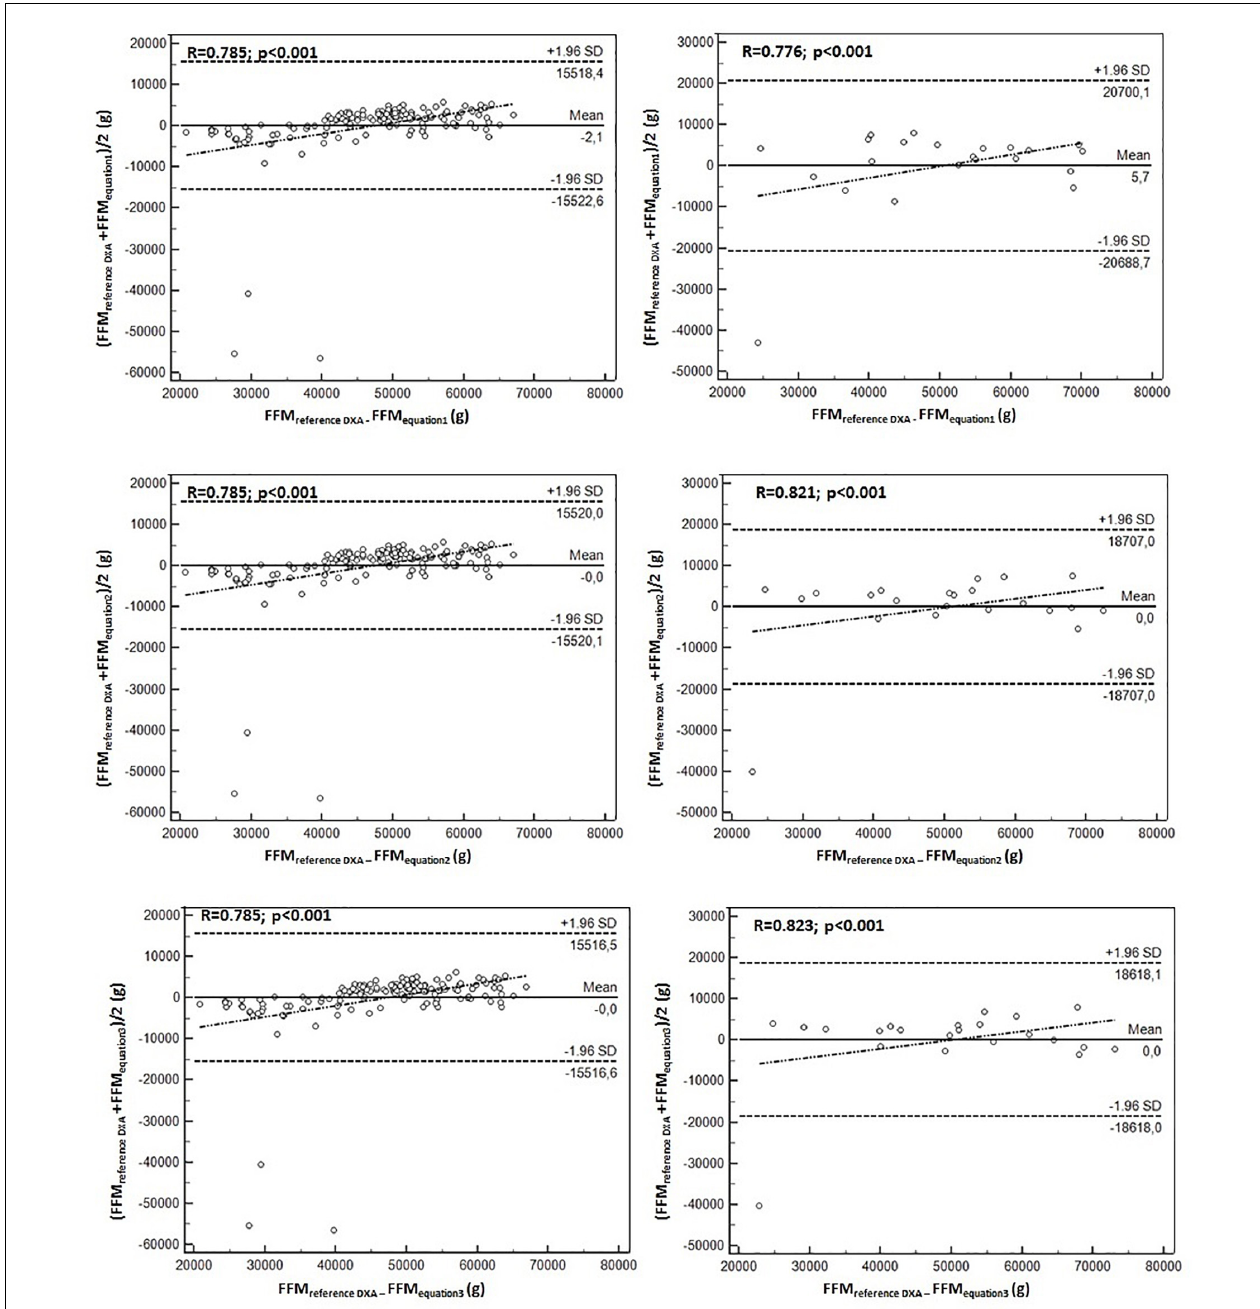
FIGURE 1 | Bland–Altman plot for the correlation between the FFM values determined by the reference method (DXA) and the three predictive equations for goalkeepers (left) and field players